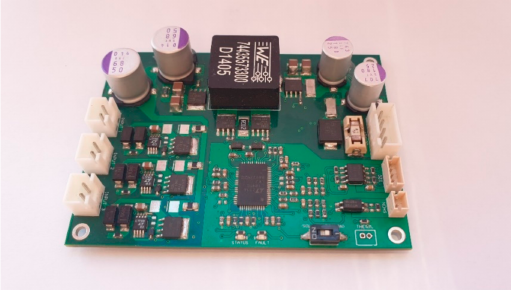
Figure 12. Photograph of the developed